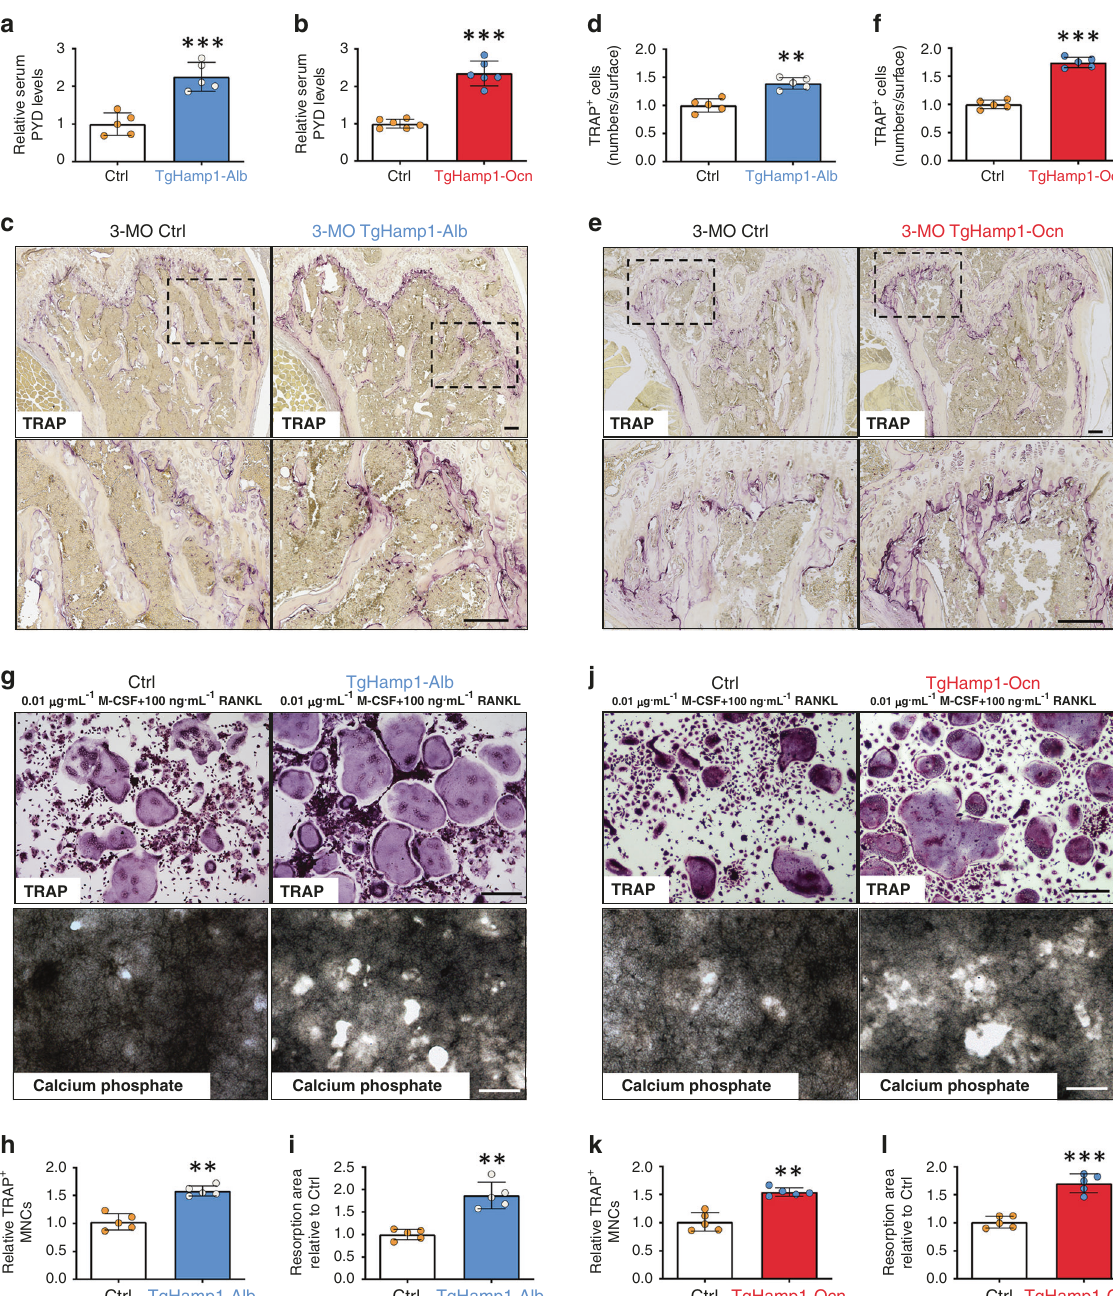
Fig. 3 Increased bone resorption in 3-month-old TgHamp1-Alb and TgHamp1-Ocn mice. a , b Analysis of serum PYD levels in 3-month-old male Ctrl, TgHamp1-Alb and TgHamp1-Ocn littermates by ELISA. The mean ± SD of measurements from fi ve different mice of each genotype and relative to the Ctrl group are shown. *** P < 0.001; NS, no signi fi cant difference. c , e TRAP staining analysis of femur sections from 3-month- old Ctrl, TgHamp1-Alb and TgHamp1-Ocn mice. Bar, 150 μ m. d , f The values are shown as the mean ± SD of measurements from fi ve different male mice of each genotype. ** P < 0.01; *** P < 0.001; NS, no signi fi cant difference. g , j TRAP staining and bone resorption pit analysis of cultured OCs derived from BMMs from mice of different genotypes on day 7. Cells were treated with 0.01 μ g·mL − 1 M-CSF and 100 ng·mL − 1 RANKL for 7 d. Bar, 200 μ m. For the bone resorption pit assay, OCs were cultured in plates coated with calcium phosphate matrix. h , k The number of TRAP + multinucleated cells (MNCs; more than three nuclei) per randomly selected visual fi eld is shown in ( g ) and ( j ). The data are presented as the mean ± SD of fi ve or six different cell culture experiments. ** P < 0.01. i , l Resorptive activity was quanti fi ed based on the mean resorption area in ( g ) and ( j ). The data are presented as the mean ± SD of fi ve different cell culture experiments. ** P < TgHamp1-Alb, TgHamp1-Ocn, and control mice. Cultured BMMs Hepcidin promotion of the proliferation, differentiation, and derived from TgHamp1-Alb and TgHamp1-Ocn mice showed activation of cultured OC progenitor cells more TRAP + OCs than cultured BMMs derived from control mice We then asked whether hepcidin regulates OC formation and resorptive activity in vitro. To this end, we fi rst evaluated M-CSF- on day 5 of RANKL treatment (Fig. 3g, h, j, k), indicating that more and RANKL-induced OC differentiation of BMMs derived from OC progenitors were present in the cultured BMMs derived from